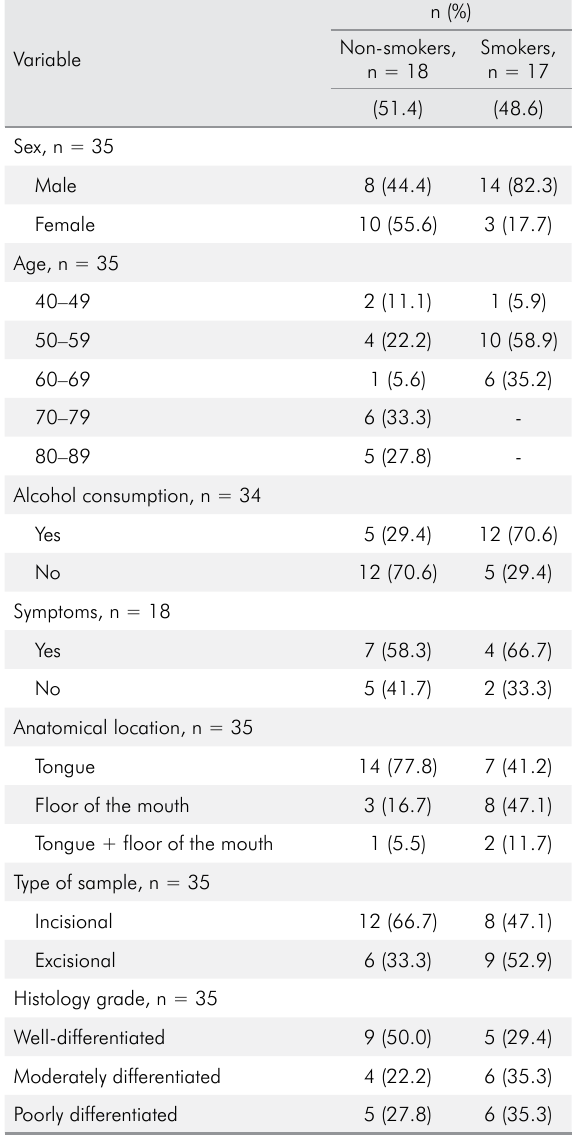
Table. Demographic data and clinicopathological characteristics of the